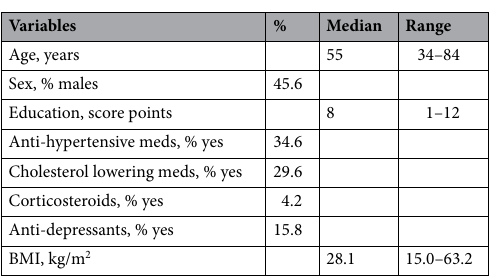
Figure 1. Sphingolipid biochemistry. ( A ) Sphingolipid structure showing the functional group (R) that defines a class and the bound fatty acid that characterizes species based on the number of carbon atoms and double bonds. ( B ) Sphingolipid metabolic pathways. The class referred in the text to as hexosylceramides includes glucosylceramides and galactosylceramides.